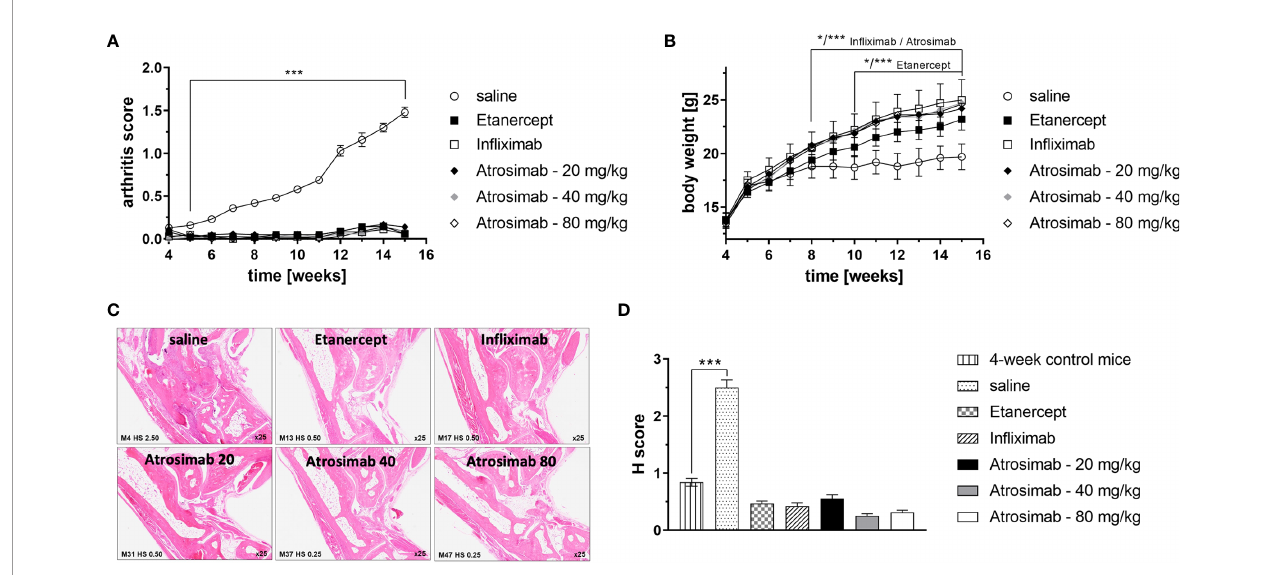
FIGURE 4 | Atrosimab prevents development of arthritic disease. Tg197hTNFR1KI transgenic mice were used as a model of experimental arthritis. Treatment (s.c.) with saline, the anti-TNF therapeutics Etanercept or In fl iximab (20 mg/kg each), or different doses of Atrosimab was started at 4 weeks of age and repeated twice weekly. Arthritis score (A) and weight (B) were documented weekly. (C, D) Histopathological analysis of the joints was performed at an age of 15 weeks and compared to 4-week-old non-treated mice. Shown are (C) representative pictures and (D) quanti fi cation of the histological (H) score. Mean ± SD, n=8, *p < 0.05, ***p <